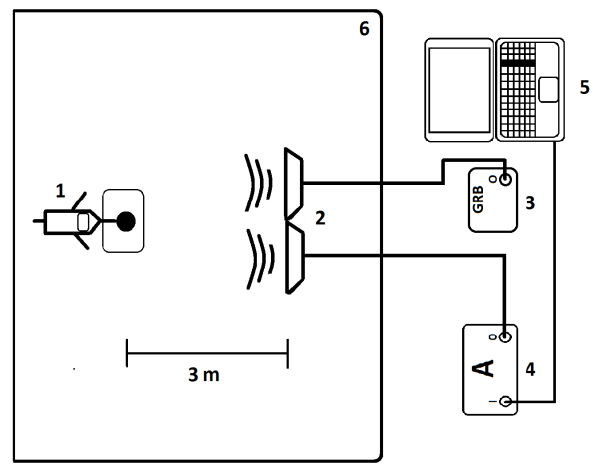
Figure 5: Experimental set-up diagram for laboratory sound signal analysis: 1. Sound level meter / Listener; 2. Loudspeakers; 3. Sound signal generator; 4. Measuring amplifier; 5. Real time analyser; 6. Anechoic